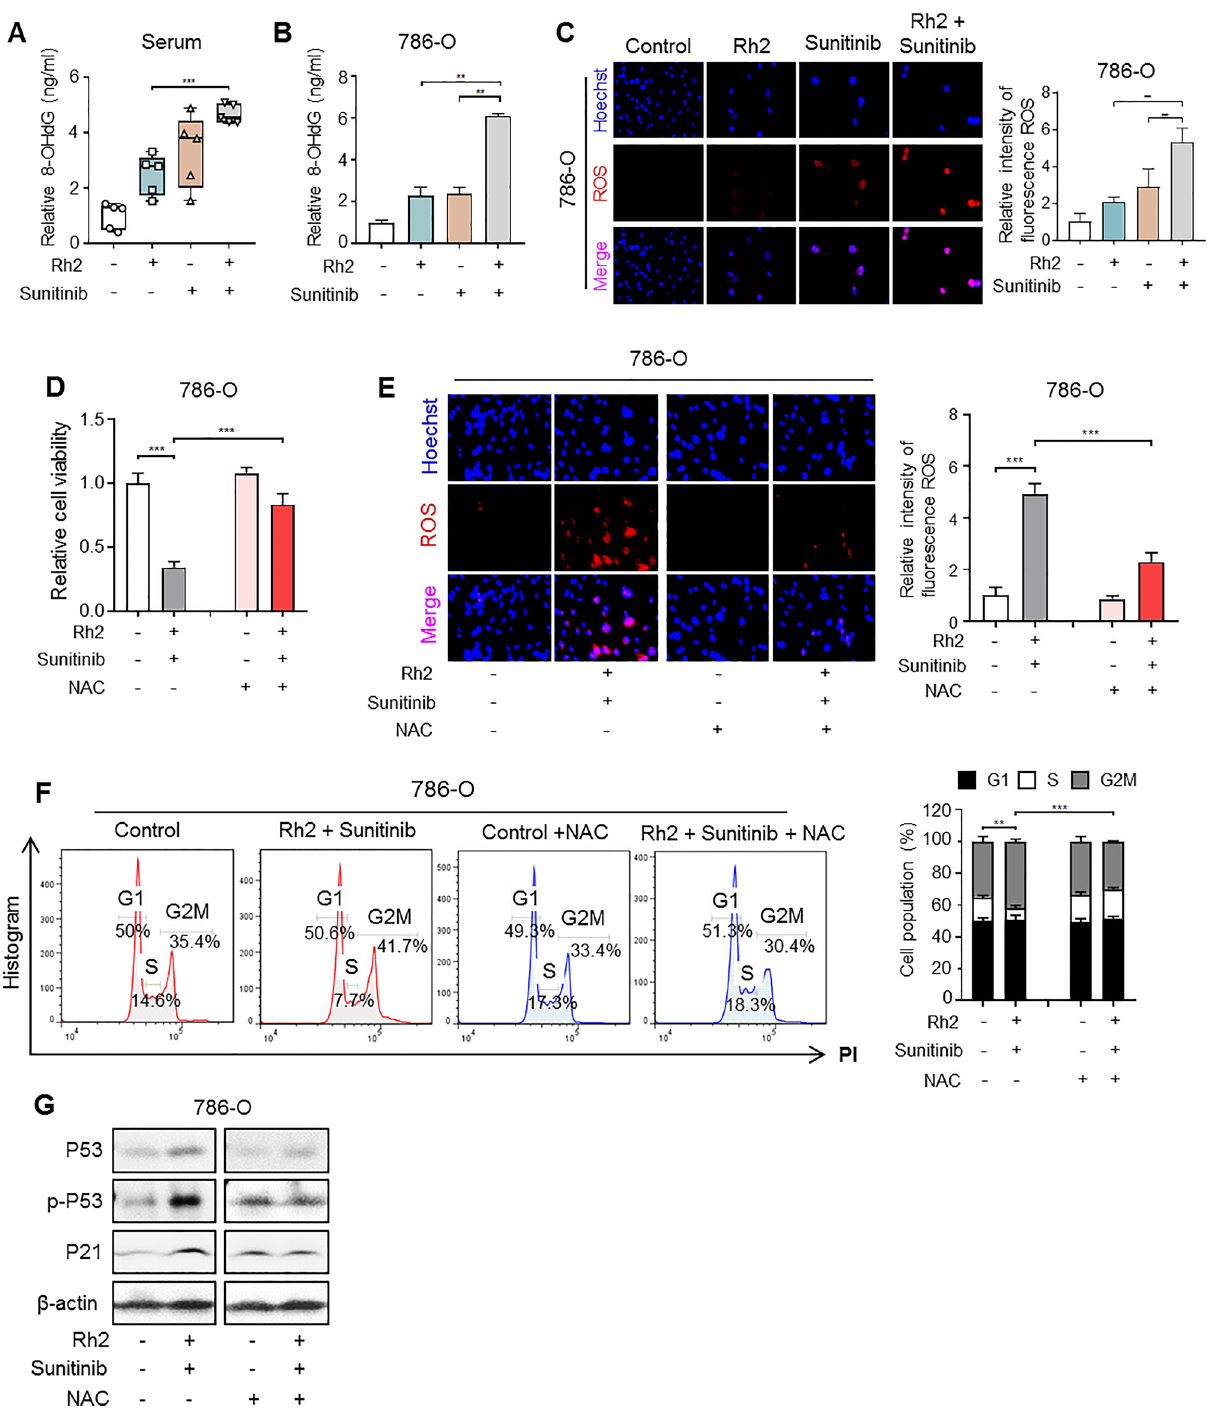
Figure 4. ROS generated by ginsenoside and sunitinib increases levels of 8-OHdG, an oxidative DNA damage marker, in 786-O cells. ( A ) Levels of 8-OHdG in serum samples of xenograft mice were measured by competitive ELISA (***p < 0.001). (n = 5). ( B ) 8-OHdG levels of 786-O cells treated with Rh2 and sunitinib (**p < 0.01). Perform at least three biological repeats (n = 3). ( C ) Fluorescent images of ROS (red) were evaluated in live cells treated with Rh2 and sunitinib. Hoechst (blue) was used as a counter stain. (400 × magnification). ( D ) Changes in cell viability when NAC, a ROS inhibitor, is administered with Rh2 and sunitinib. NAC (5 mM), Rh2 (10 μM), and sunitinib (10 μM) (***p < 0.001). (n = 3). ( E ) ROS induced by sunitinib and Rh2 was alleviated by treatment with NAC. Measurements were taken 24 h after administration of the drug with a fluorescence microscope. (400 × magnification). ( F ) Cell cycle analysis by flow cytometry of 786-O cells treated with Rh2, sunitinib, and NAC. Histogram data from the cell analysis are quantified and graphed. (n = 3). ( G ) Western blot analyses to evaluate the expressions of the indicated proteins in 786-O cells that were treated with Rh2, sunitinib, and NAC. We confirmed that the protein expressions of cell cycle arrest markers were reduced by NAC. (n =